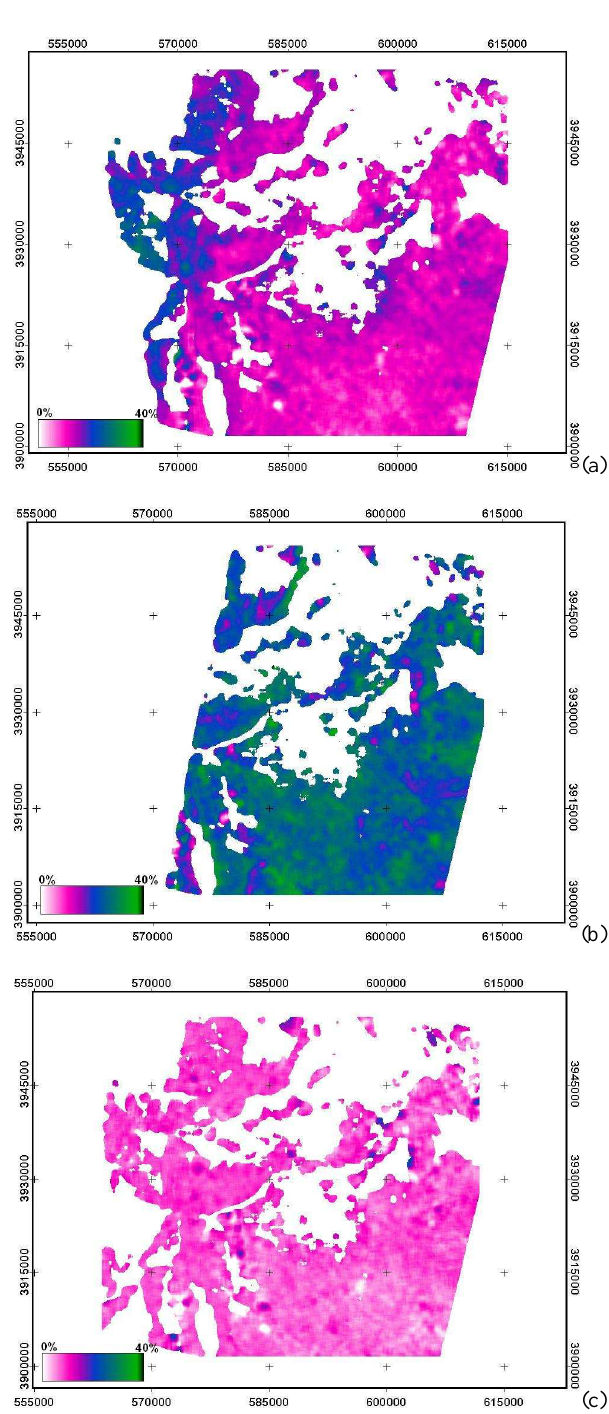
Fig. 7. Illustration of moisture mapping for an area containing fields in the “olive tree” class of land use, (a) 11 April 2009, (b) 12 April 2009, (c) 9 December 2009.